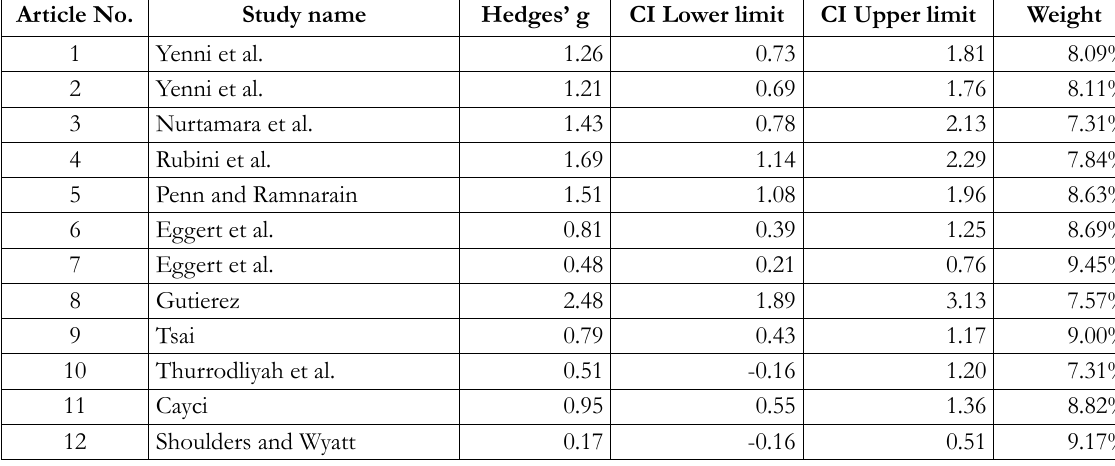
Table 6. Effect Size of 12 Research Studies